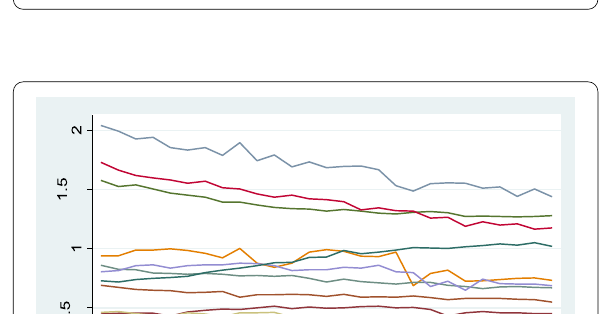
Fig. 3 EF in N11 countries